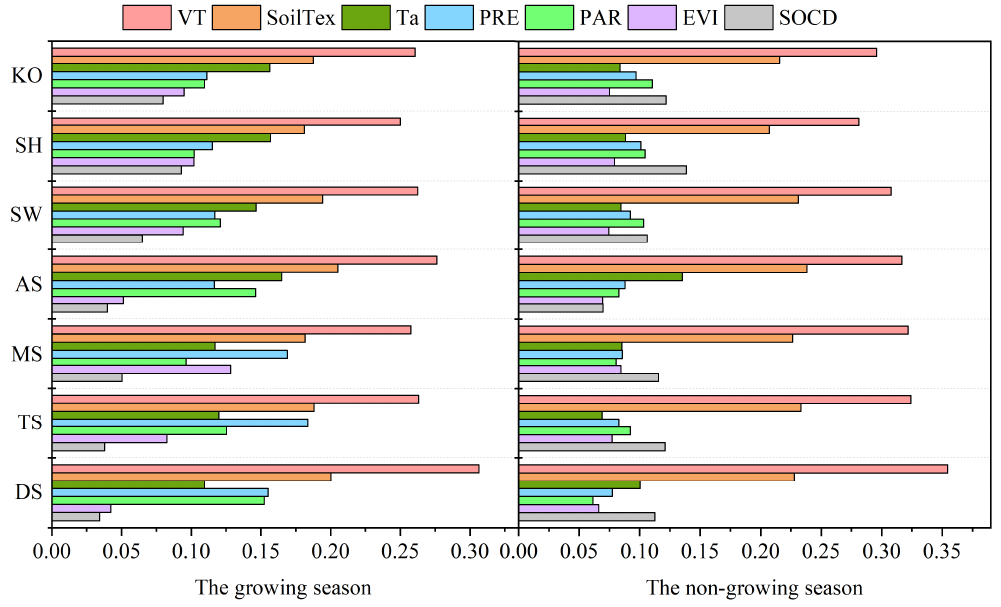
Figure 4. Relative importance of the environmental variables for predicting RE in the growing season ( left ) and non-growing season ( right ). KO: alpine Kobresia meadow. SH: alpine shrub meadow. SW: alpine swamp meadow. AS: alpine meadow steppe. MS: meadow steppe. TS: typical steppe. DS: desert steppe. Table 3. Relative importance statistics for the environmental variables. All the notations in the grass- land subtypes column are consistent with those in Figure 4.